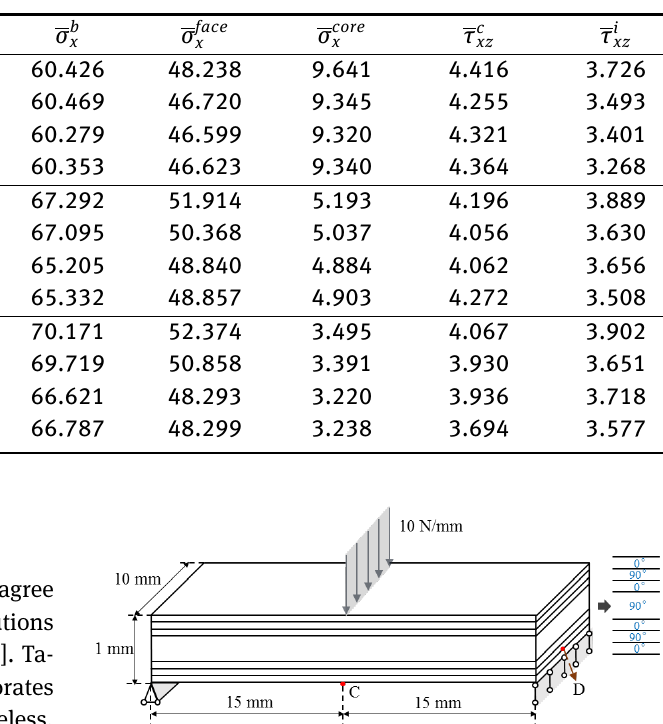
Table 2: Normalized deflections and stresses in the sandwich-like plate under the uniformly distributed load. R Models/Elements